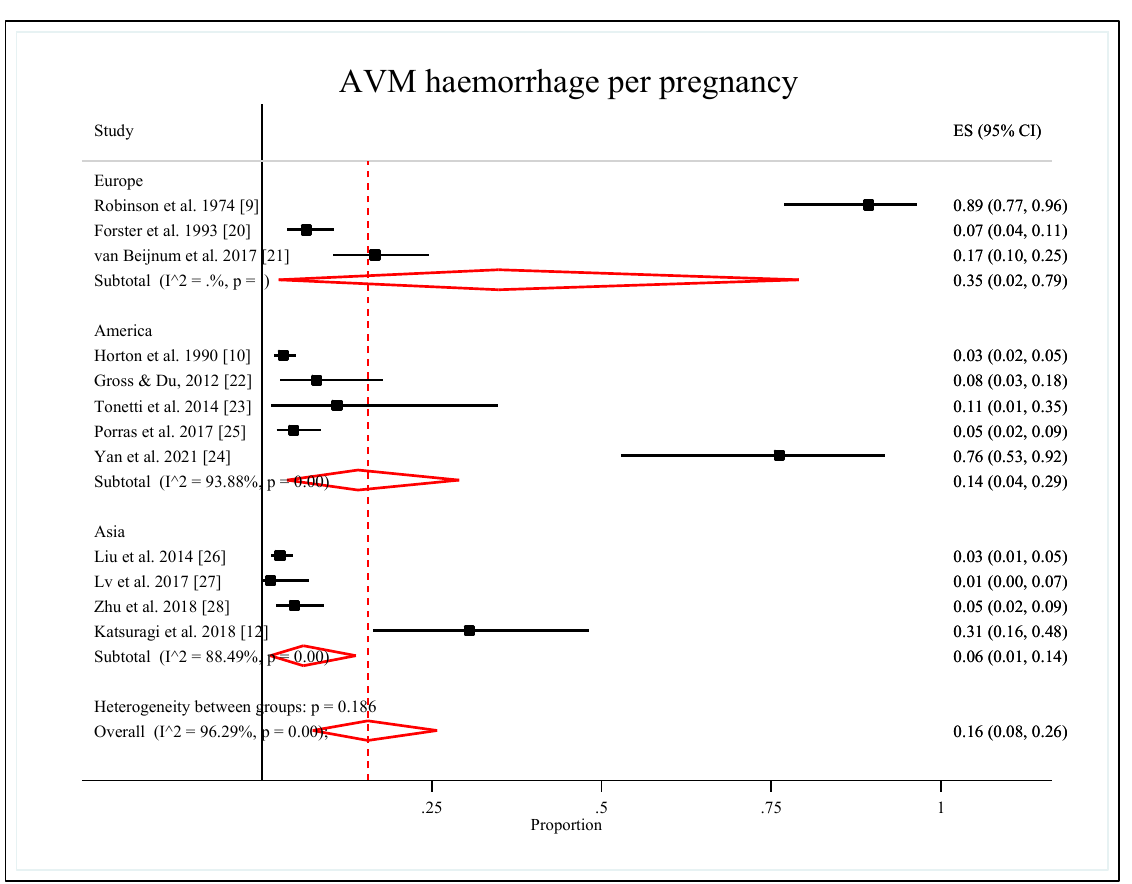
Figure 3. Forest plot of the pooled proportion of AVM hemorrhage per pregnancy by regions [9,10,12,20–28].